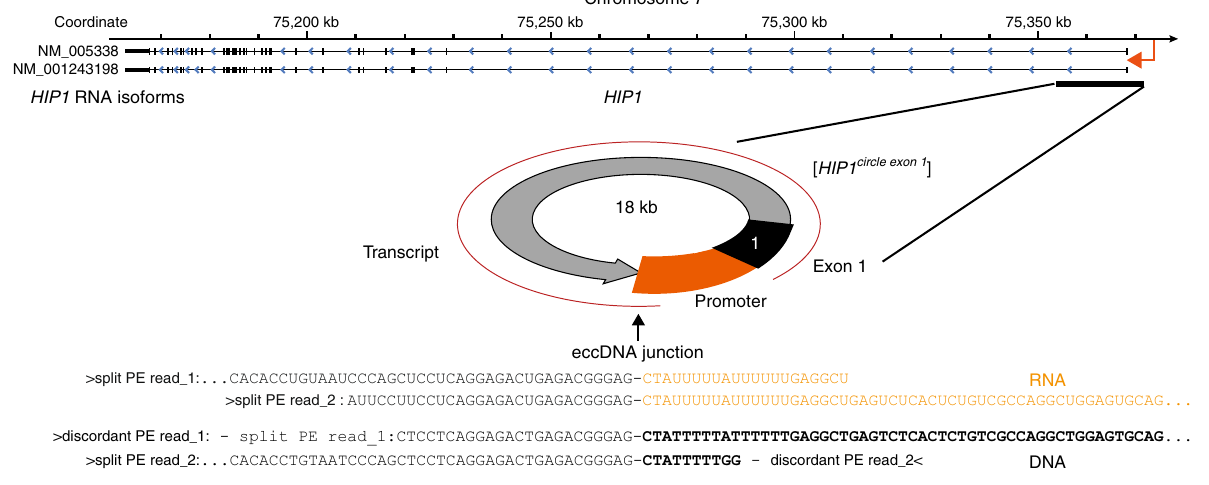
Fig. 6 EccDNA transcript from the [ HIP1 circleexon1 ]. Display of chromosome 7 at the HIP1 gene and detected [ HIP1 circleexon1 ]. The two sequenced RNA reads (black and orange text) from participant T8 overlap perfectly to the two sequenced DNA reads from participant T8 (black and bold text font)